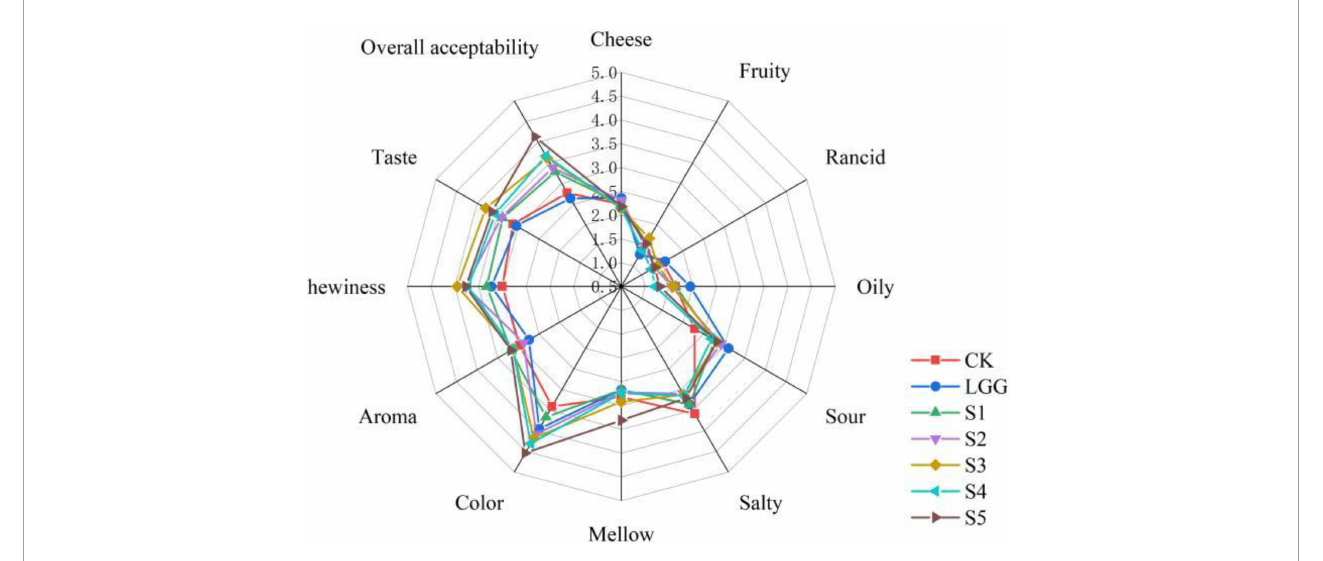
FIGURE8 Radar image of sensory evaluation scores of different fermented sausage